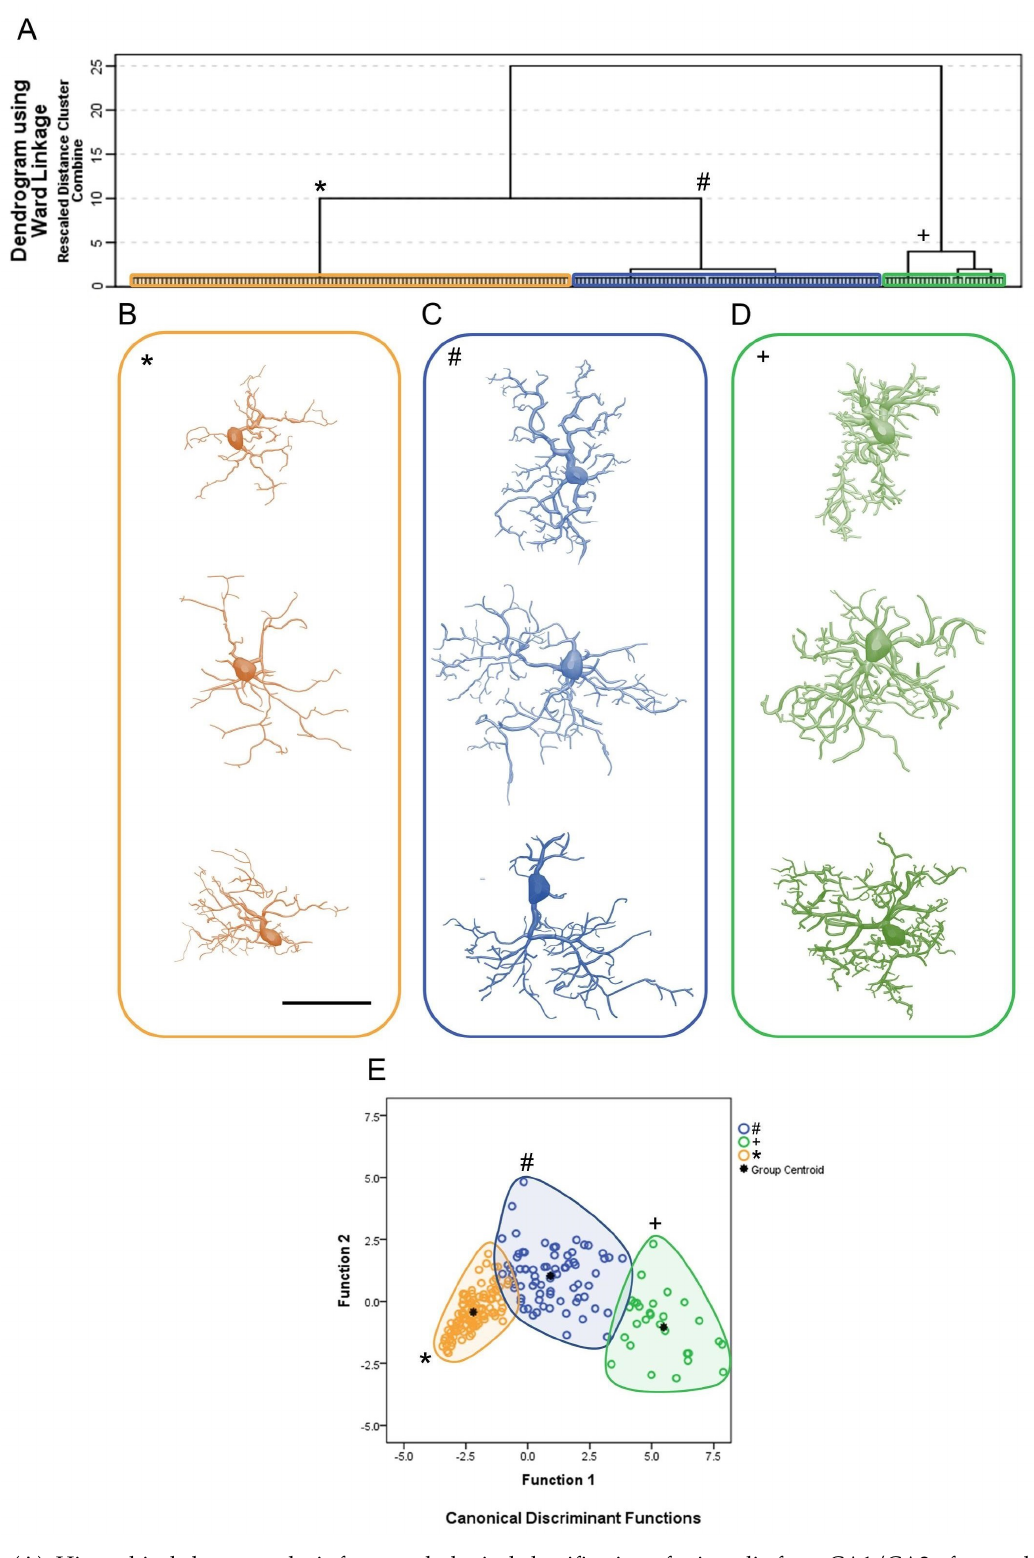
Figure 2. ( A ): Hierarchical cluster analysis for morphological classification of microglia from CA1/CA2 of control and Piry virus–infected animals at 8 days post-infection. Note the three main clusters, two of them representing microglia of infected animals (cluster 1, blue/#; cluster 2, green/+) and another representing microglia of the control group (cluster 3, orange/*). The morphometric variables used in the analysis were those with a MMI above 0.55 with at least bimodal distribution; ( B – D ): Representative cells of each cluster based on the greatest, median, and shortest distances between pairs, after